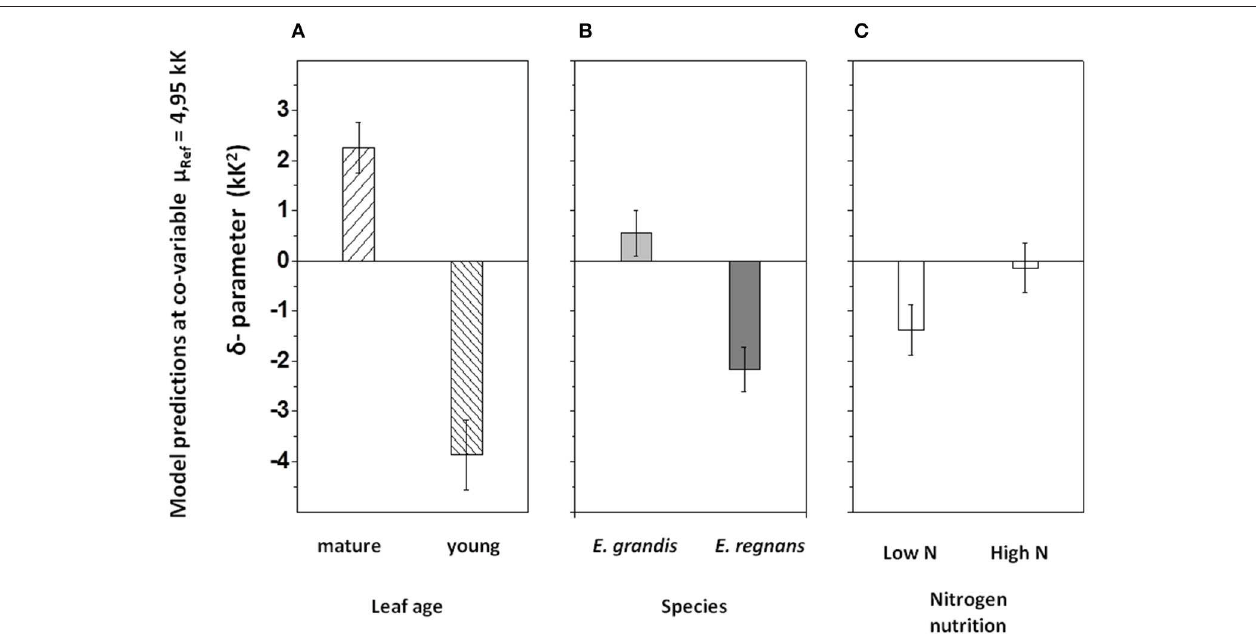
FIGURE 9 | Effects of categorical predictor variables on δ R , after accounting for the linear dependency on µ Ref ( = E o (Ref.)/ R ) as co-variable in ANCOVA. (A) Leaf age -dependent effect. (B) Species-dependent effect. (C) Nutrition-related effect. Values shown are predicted δ R -values within ± 95% confidence intervals at µ Ref = 4,95 kK (i.e., the x-axis intercept of the regression between exponent parameters; compare Figure 7B ). The parameter δ R defines the shape of log-polynomial temperature responses of leaf R. For δ R > 0 the shape is concave upwards, and for δ R < 0 it is convex downwards (compare Figure 1B ). For further information on effect sizes on δ R in ANCOVA, see Table 4B